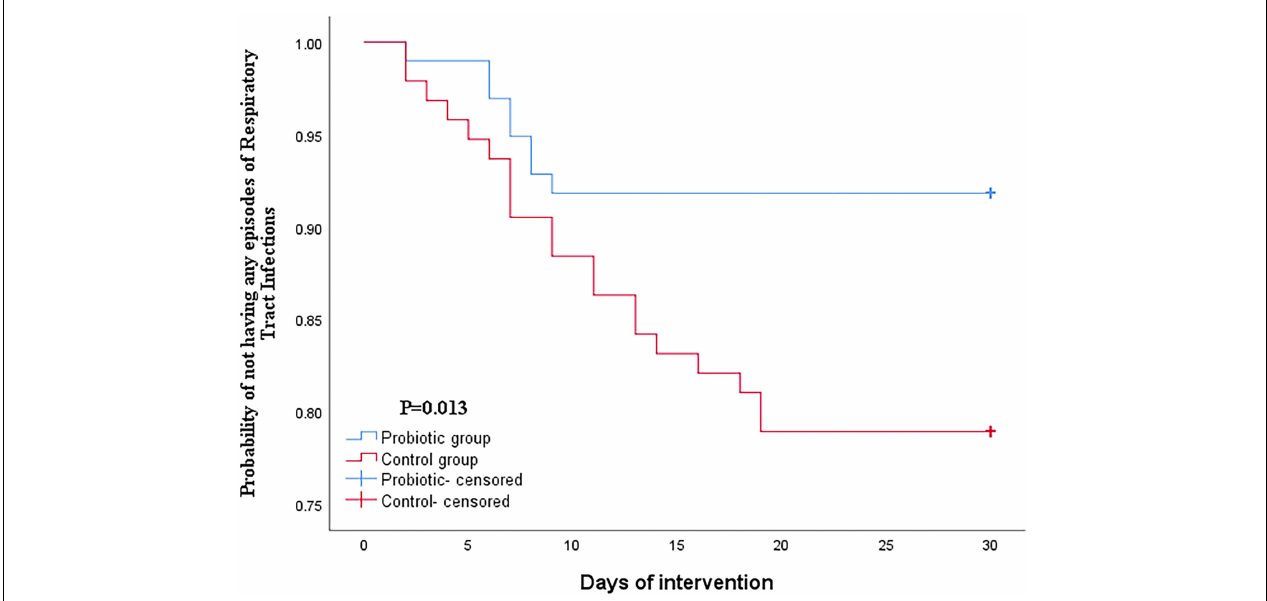
FIGURE 1 | Kaplan–Meier curves of the cumulative incidence